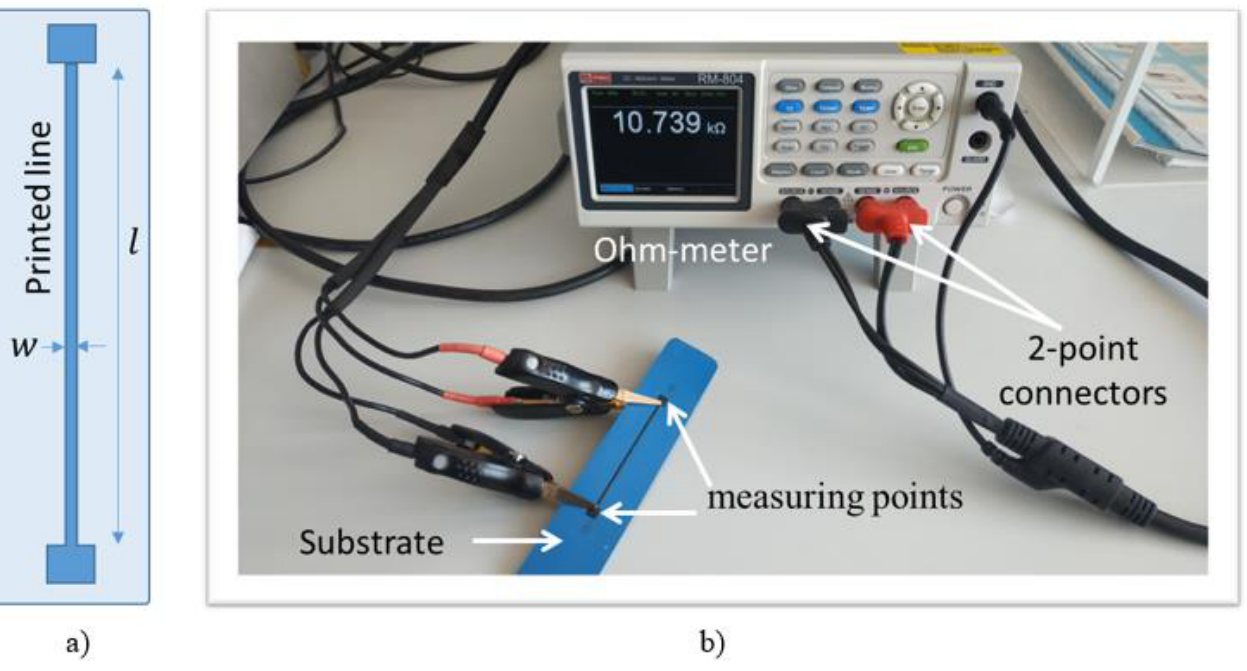
Figure 5. ( a ) Conductive coating printed on a 2D substrate; ( b ) experimental setup used for measurement of electrical resistance.